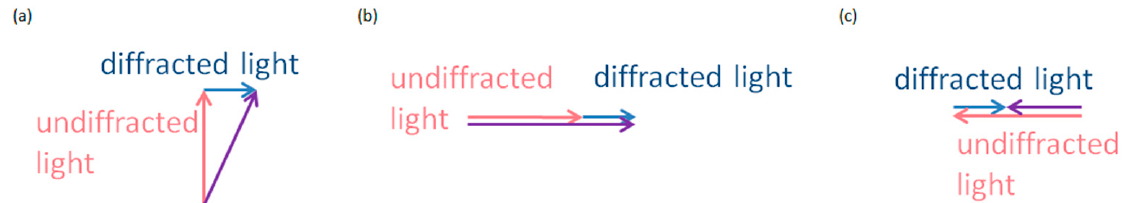
Figure 2. ( a ) Diffracted light (indicated in blue) has a − 90 ◦ phase shift compared to the background (indicated in red). The interfered wave (indicated in purple) is the vector sum of the diffracted light and the background. It has an intensity (indicated as the magnitude of the vector) similar to the background. ( b ) The phase ring has been inserted so that the undiffracted light is phase-shifted by − 90 ◦ compared to ( a ). The intensity of the interfered wave is the sum of undiffracted and diffracted light, which results in an increase in intensity with constructive interference. ( c ) Opposite to the condition in ( b ) where the background wave is phase-shifted by 90 ◦.